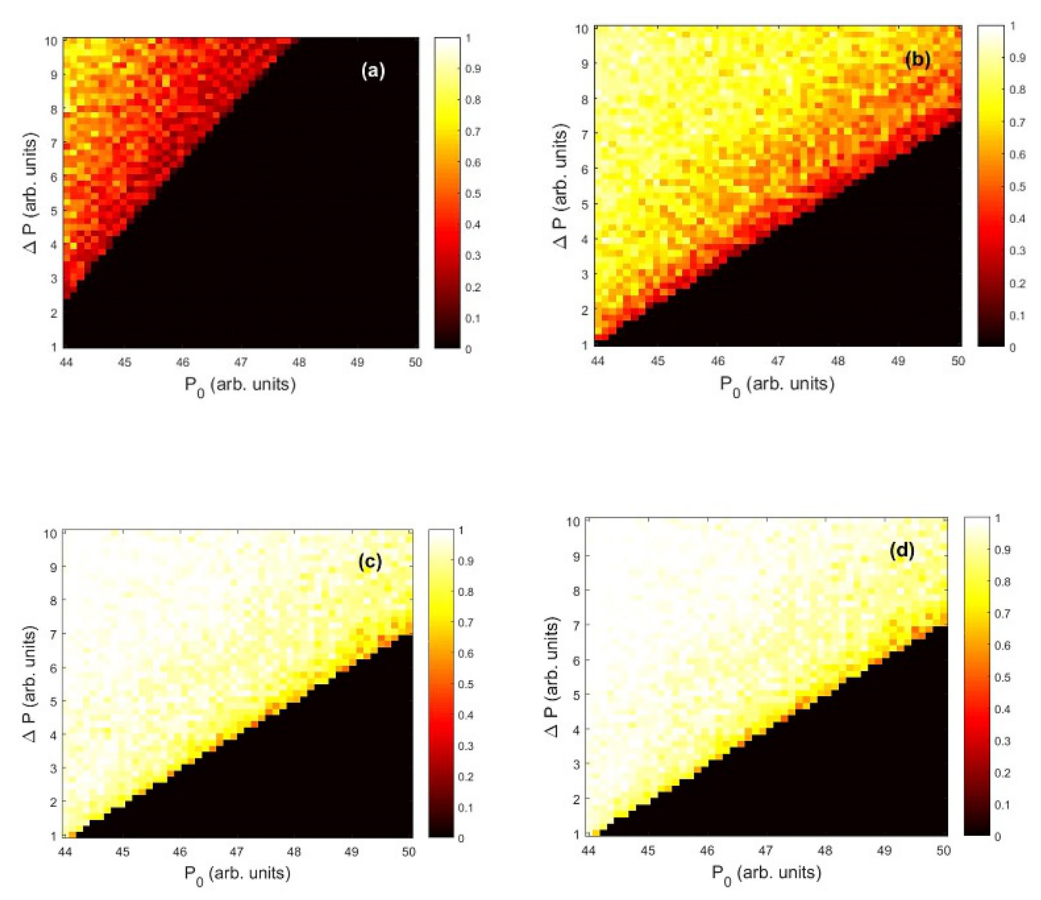
Figure 5. Success rate as a function of P 0 and ∆ P . The duration of the perturbation is ∆ T = 5 ns ( a ), 10 ns ( b ), 20 ns ( c ), 30 ns ( d ). The detection time interval is 5